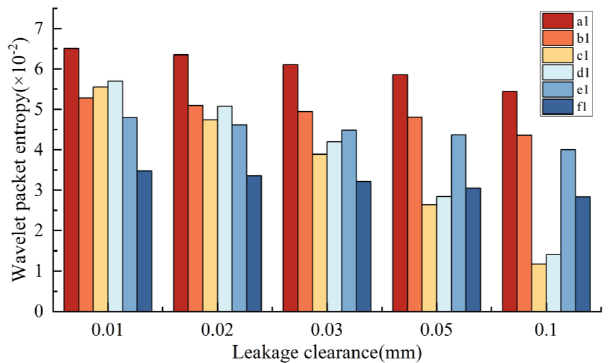
Figure 19. Fault feature of leakage in reversing valve.